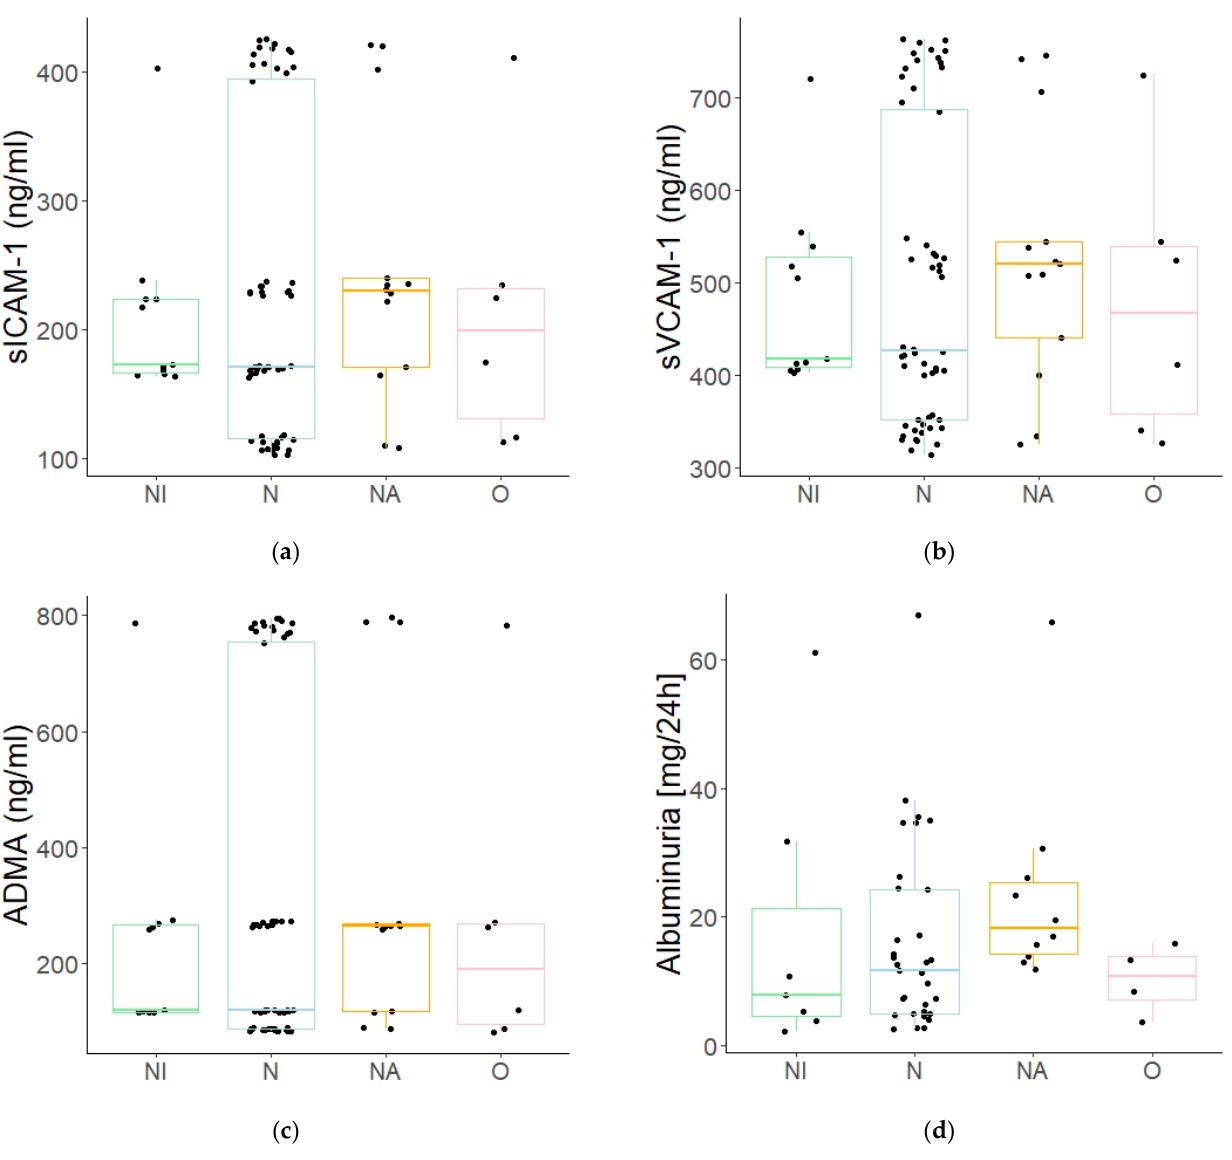
Figure 3. ( a – d ). A comparison of selected parameters depending on BMI (( a )—the mean sICAM-1 values: 209.94 ± 70.31 vs. 279.44 ± 108.54 vs. 269.65 ± 96.13 vs. 261.02 ± 103.28 ng/mL; ( b )—the mean sVCAM-1 values: 481.18 ± 99.39 vs. 568.94 ± 141.01 vs. 560.93 ± 117.07 vs. 550.41 ± 129.89 ng/mL; ( c )—the mean RAGE values: 231.46 ± 198.32 vs. 414.20 ± 298.22 vs. 380.62 ± 269.90 vs. 357.74 ± 291.02 pg/mL; ( d )—the mean albuminuria values: 17.51 ± 21.68 vs. 15.81 ± 14.41 vs. 23.67 ± 16.08 vs. 10.23 ± 5.41 mg/24 h). Boxplot of values for each subgroup. Legends: NI—the patients underweight patients, n = 11; N—the patients with normal body weight, n = 39; NA—the overweight patients, n = 11; O—the patients with obesity, n = 4.